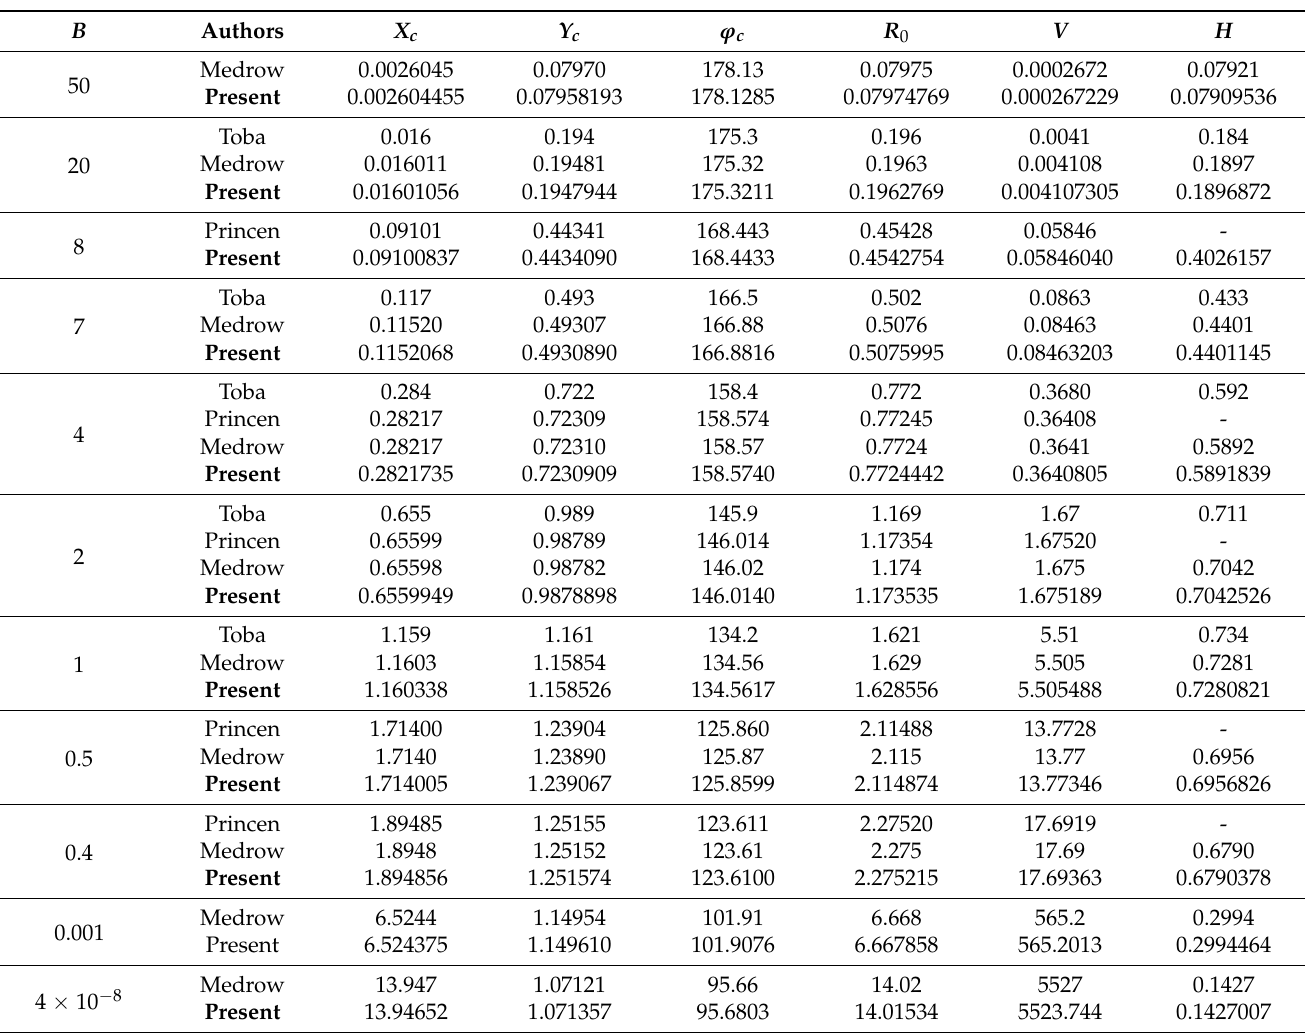
Table 1. Comparison of the present numerical results with those of Toba [29], Princen [30], and Medrow and Chao [31] for the selected bubble